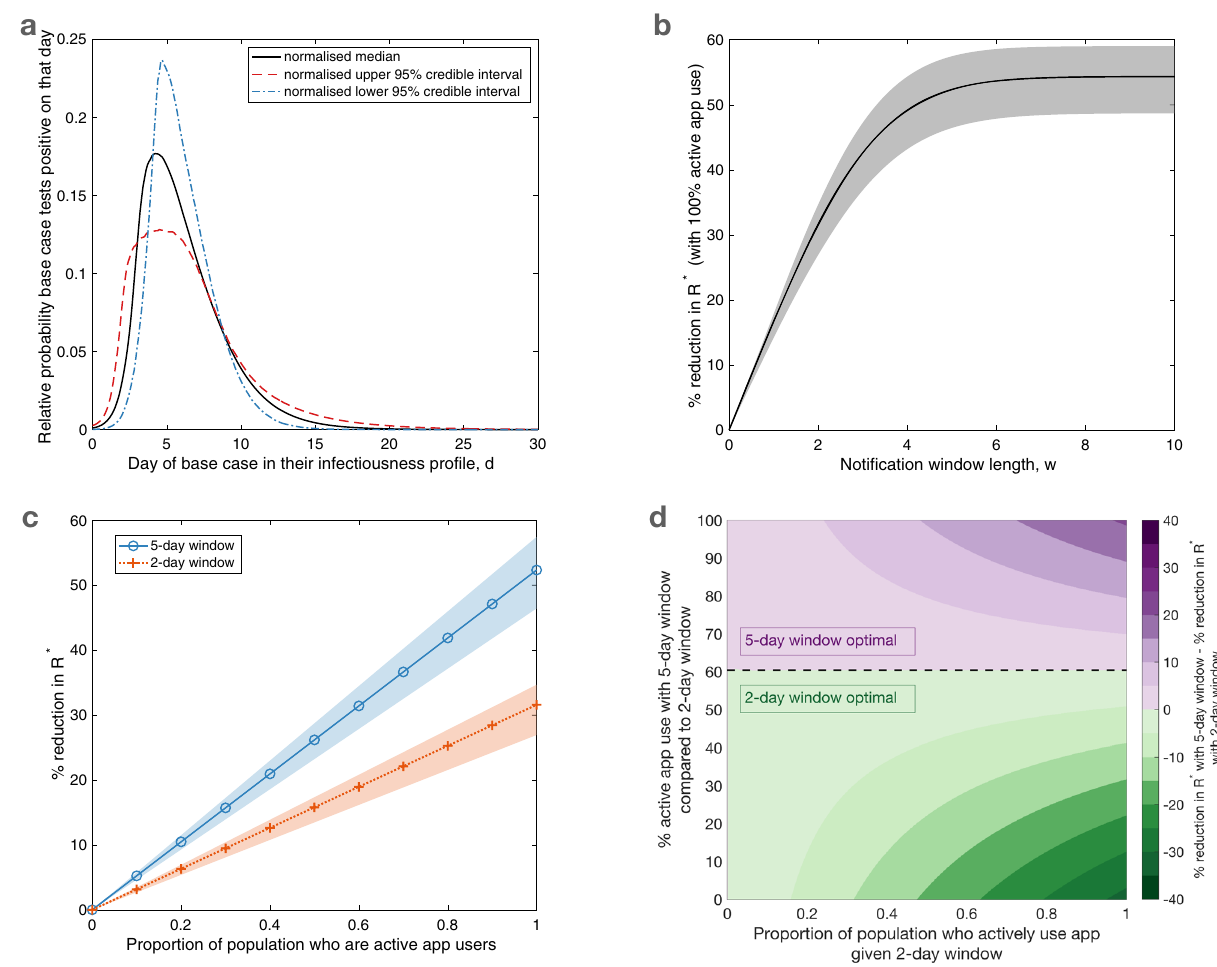
Fig. 2 Impact of the noti fi cation window length and active app use on transmission. a The relative probability of the base case testing positive on a given day in their infectiousness pro fi le, obtained by normalising the median (black, solid line) positive test probability pro fi le for LFTs taken by asymptomatic, infected individuals 7 . Normalised 95% credible interval test probability pro fi les 7 (upper - red, dashed line; lower - blue, dot-dashed) are also considered, to obtain shaded regions in ( b ) and ( c ). b The percentage reduction in R * for different length noti fi cation window w , relative to a scenario in which a noti fi cation app is not used, under the assumption that all individuals are active app users (i.e. 100% adherence). c The relationship between the proportion of primary cases who are active app users and the percentage reduction in R * for a 5-day noti fi cation window (blue solid line, circle markers) and a 2-day noti fi cation window (orange dotted line, cross markers). d A heat map indicating the transmission reduction achieved by using a 5-day window rather than a 2-day window, quanti fi ed by the difference in the percentage reduction in R * that results from a 5-day noti fi cation window compared to a 2-day noti fi cation window. The proportion of primary cases assumed to be active app users for a 2-day window is shown on the x -axis, and the relative level of active app use assumed for a 5-day window (compared to the level of active app use for a 2-day window) is shown on the y -axis. Purple (green) regions correspond to where 5-day (2-day) noti fi cation windows lead to a larger reduction in R *